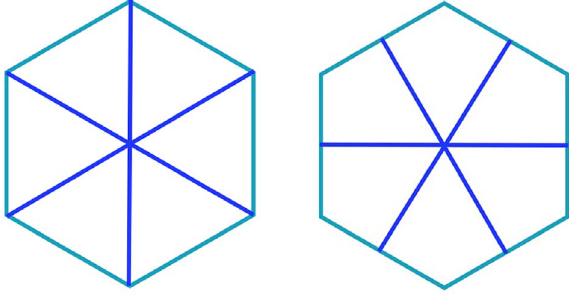
Figure 38. Converting VV max into SS cut through centre of the sides by rotation.